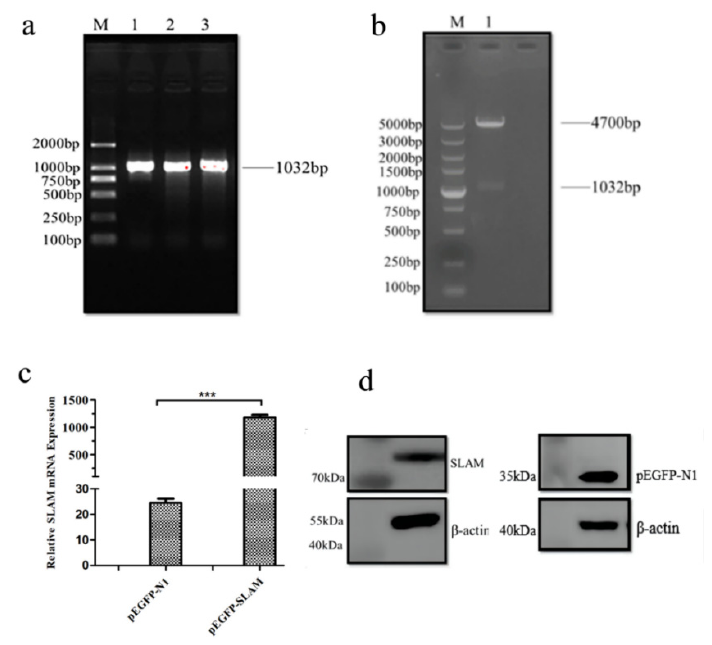
Figure 1. pEGFP-N1-SLAMF increases SLAM level. ( a ) The PCR product of the SLAM gene. M: DL2000 Marker; Line1~3: gene fragment of SLAM. ( b ) Double enzyme digestion product of pEGFP-N1-SLAM. M: DL5000 Marker; 1: The result of pEGFP-N1-SLAM digested with a restriction enzyme. ( c ) Relative SLAM mRNA level was determined by qRT-PCR; Note: the pEGFP-SLAM group compared with the pEGFP-SLAMF1 group: *** means extremely significant difference ( p < 0.001). ( d ) SLAM protein was determined by western blot.